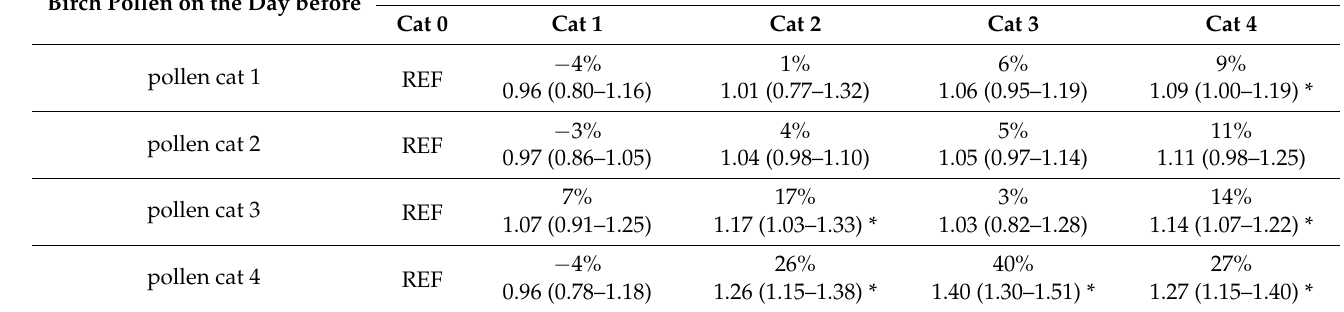
Table 4. The change (%) in the number of daily outpatient visits due to respiratory causes related to the birch pollen concentrations (pollen grains/m 3 /day; in five categories) and the number of lightning discharges per day (in five categories) on the day before. The post-estimation β coefficient values, including the confidence interval (CI) values at the 95% significance level, are depicted below the change estimate (%). Significant results are marked with *. Adjustment for the season time was performed using sinus–cosinus, linear and quadratic